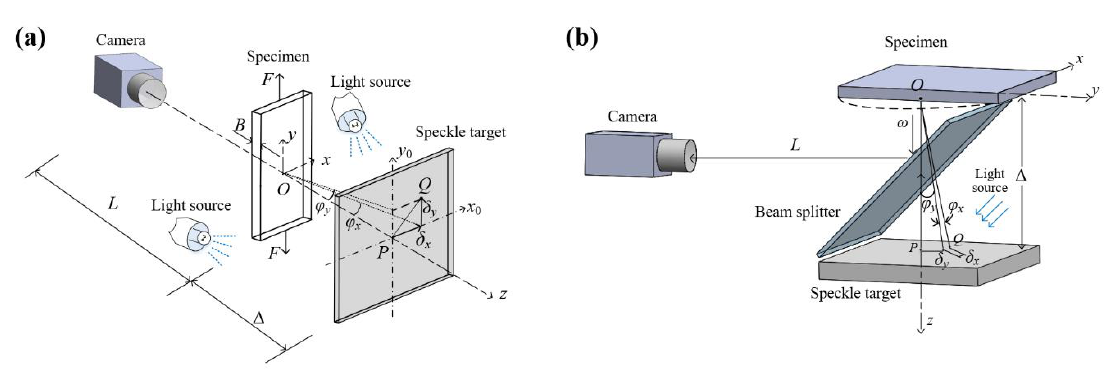
Figure 1. Schematics of ( a ) transmission-mode DGS, ( b ) reflection-mode DGS.